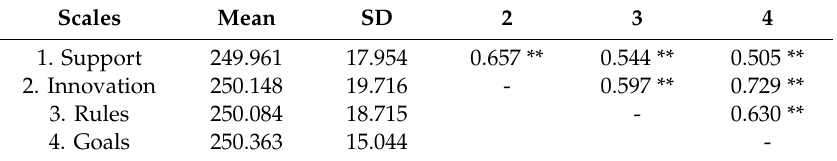
Table 2. Means, standard deviations, and organization-level correlations ( n = 152).